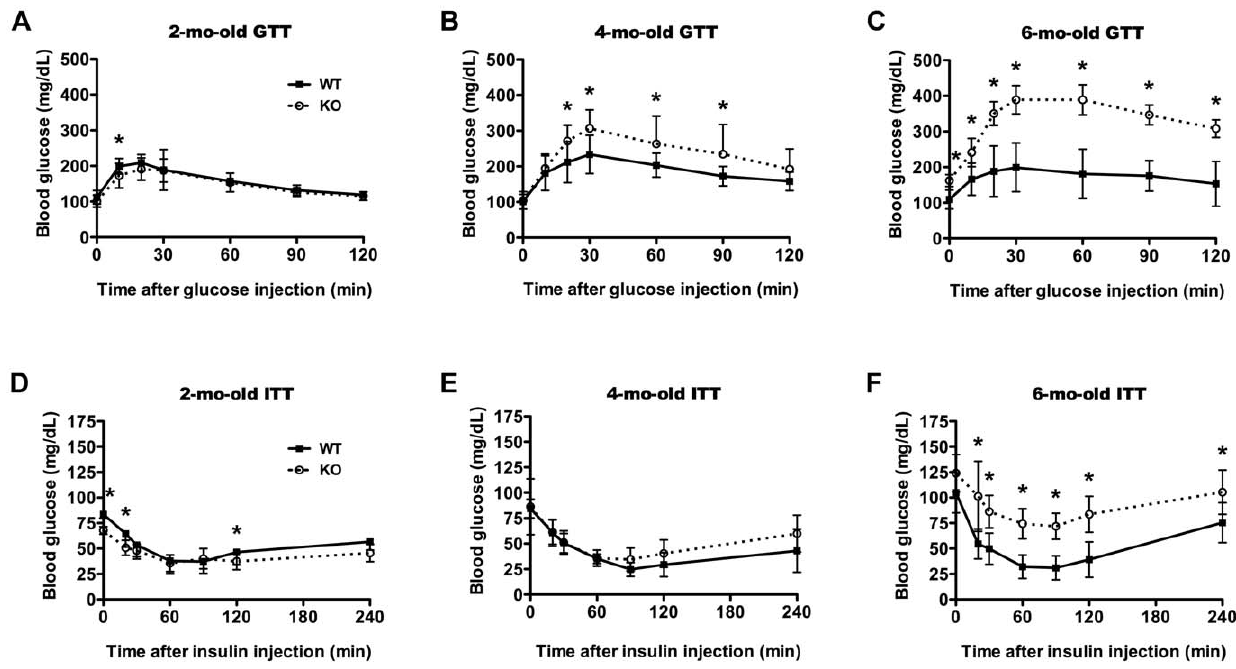
Figure 3. Age-dependent emergence of the diabetic phenotype in IDE-KO mice. A – C , Glucose tolerance tests in 2- ( A ), 4-( B ), and 6-mo-old ( C ) wild-type (WT) and IDE-KO (KO) mice. Note that 2-mo-old IDE-KO mice exhibit improved glucose tolerance at some time points. Data are mean 6 s.d. of 10–12 mice per condition. *P , 0.05. D – F , Insulin tolerance tests in 2- ( D ), 4-( E ), and 6-mo-old ( F ) WT (WT) and IDE-KO (KO) mice. Note the trend towards improved insulin tolerance in 2-mo-old IDE-KO mice. Data are mean 6 s.d. of 10–12 mice per condition. *P , 0.05 IDE-KO vs. WT as determined by 2-tailed Student’s t test.